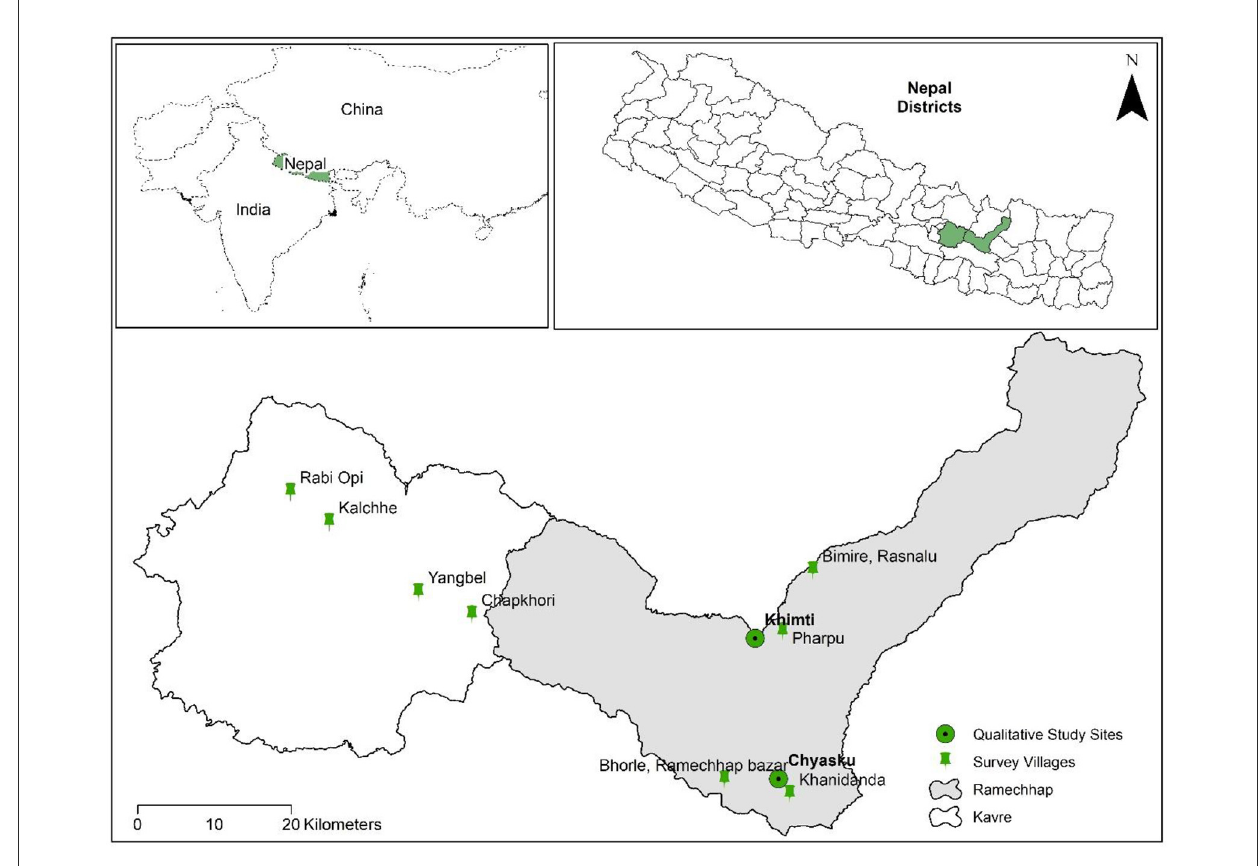
FIGURE1 Map: Case study and quantitative survey